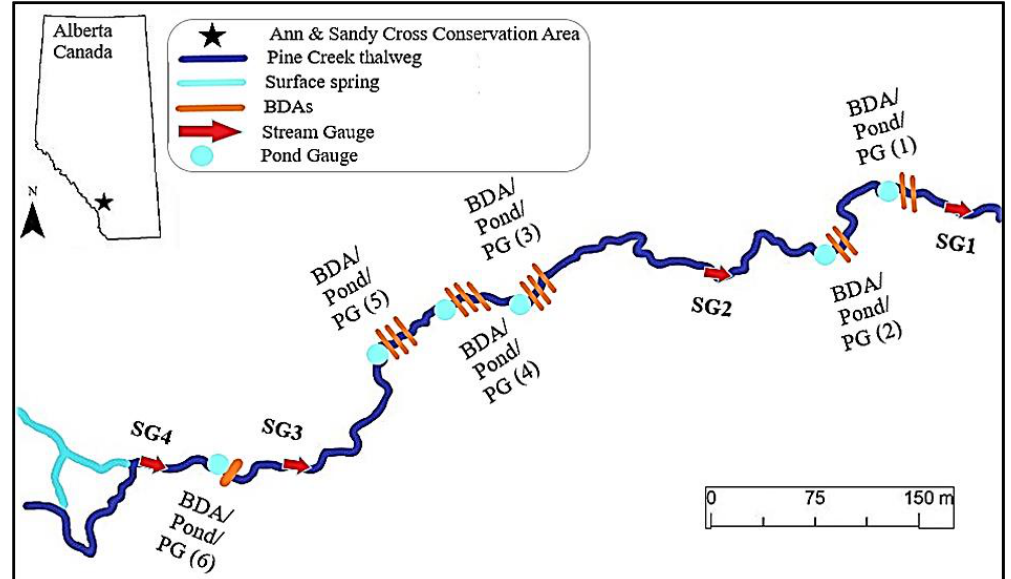
Figure 1. Study stream fitted with beaver dam analogue (BDA) configurations, pond gauges (PG) and stream gauges (SG) at Ann and Sandy Cross Conservation Area, 30 km SW of Calgary in Alberta, Canada (50°51 ′ N, 114°13 ′ W). Six BDAs (BDA6–BDA1) from upstream to downstream are represented by beige bars along ~1070 m long reach. 1–3 beige bars show single-, double-, and triple-configurations, respectively. Each BDA is instrumented with an upstream PG (PG6–PG1). Four SGs (SG4–SG1, represented by red arrows) before or after each of the three configuration series monitored stream stage/discharge. One surface spring fed the creek (tele-blue line). Reach and the Instrumentations are not up to the